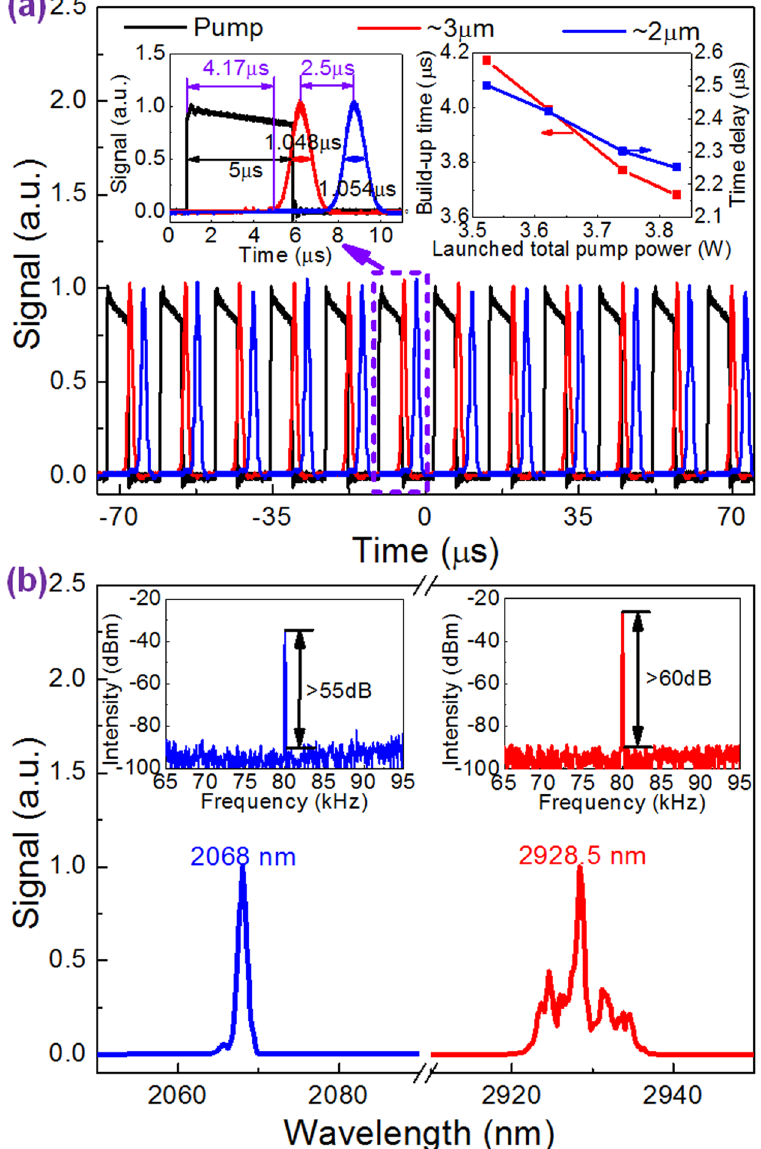
Figure 2. The output characteristics of “1-1” state. ( a ) Pulse trains and single pulse waveforms (left inset) at the LTPP of 3.52 W (LCWPP: 1.94 W, LPPP: 1.58 W), and build-up time and time delay versus the LTPP (right inset); ( b ) Optical and RF (insets) spectra at the LTPP of 3.83 W (LCWPP: 2.03 W, LPPP: 1.8